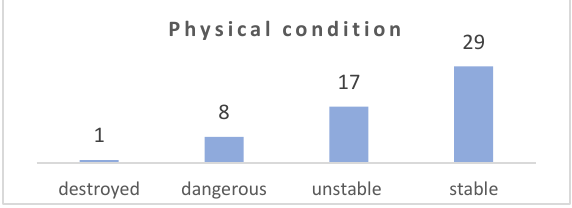
fig. 3. Physical condition distribution. d. Custodians: About 40% of the sites, 25 of the 59, are located in areas of the Nature and Parks Authority, in national parks and nature reserves. At eight of these sites, the synagogue is the reason the site was declared a national park. Eleven sites are in areas managed by local authorities, the church and the Jewish National Fund (JNF), and the 23 other sites, constituting c. 40% of the total, remain to this day without any custodian being directly involved in their preservation (Fig. 4).